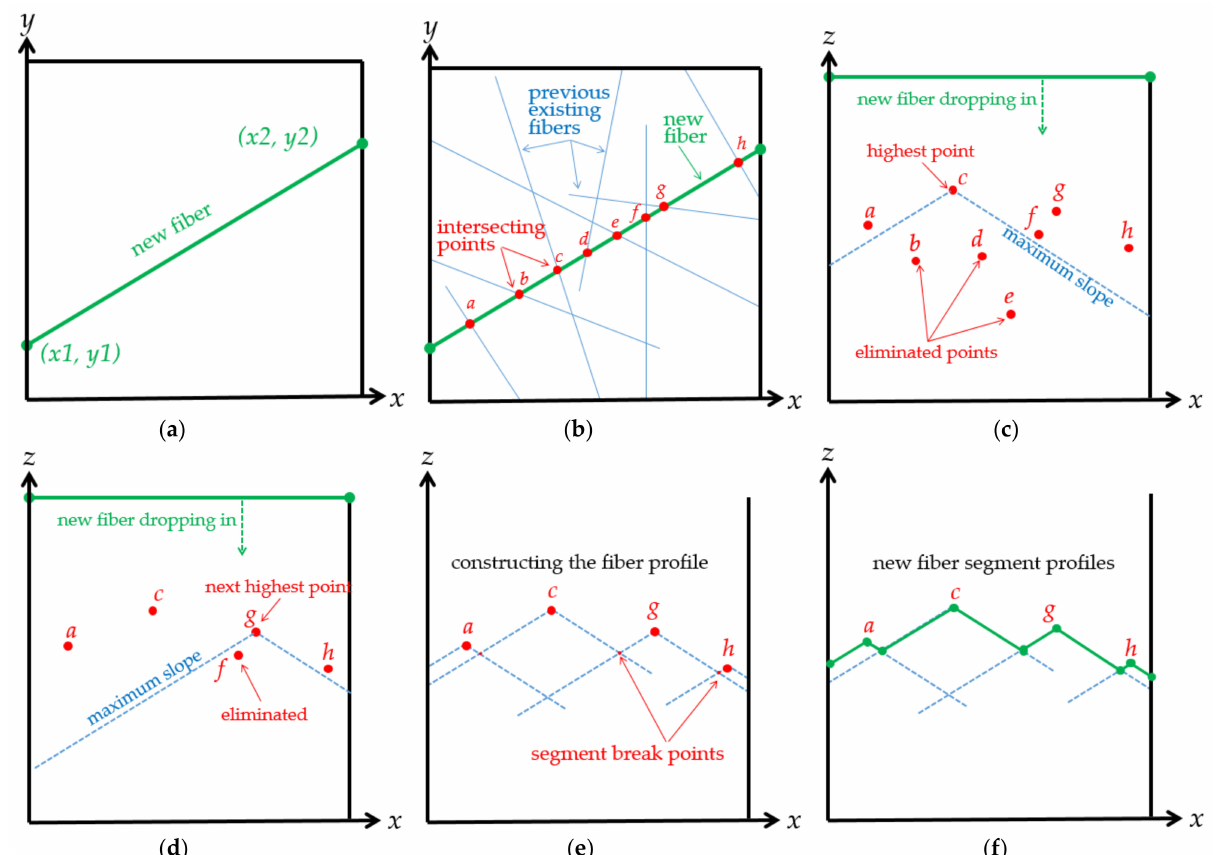
Figure 4. Process for breaking a new fiber into segments to conform to previous geometry. ( a ) New random fiber specified starting and ending points. ( b ) Potential intersection points are evaluated below the fiber. ( c ) Height of potential intersecting points are evaluated against maximum slope. ( d ) Potential intersecting points eliminated that fall below the maximum slope line. ( e ) Fiber segment profile is constructed from the remaining maximum slope lines. ( f ) New fiber segment starting and ending points are finalized.